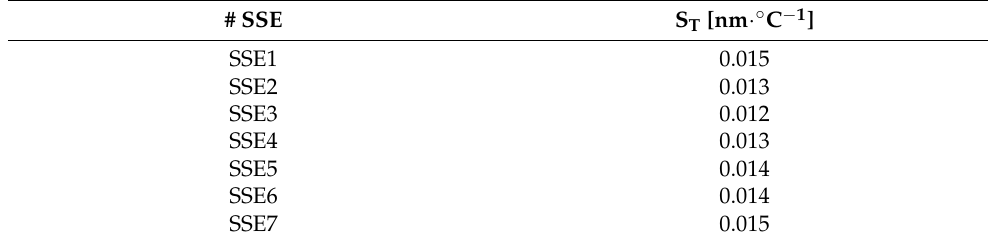
Table 2. Values of the. S T obtained for the seven SSEs.